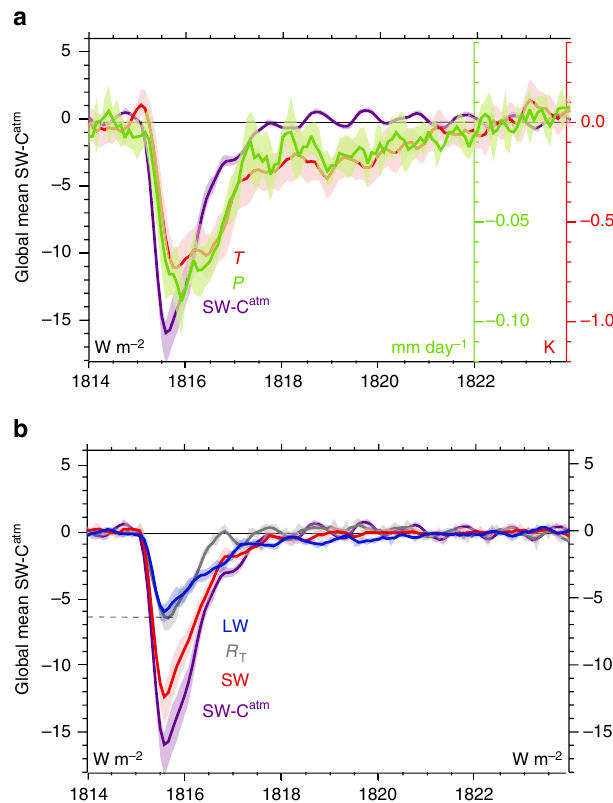
Fig. 3 Global mean-simulated responses to the 1815 eruption. Simulated anomalies relative to 1814 are shown in a global mean clear-sky shortwave fl ux through the atmosphere (SW-C atm ), 2-m air temperature ( T ), and precipitation ( P ), and b SW-C atm , global mean TOA incoming net ( R T ), shortwave (SW), and outgoing longwave (LW) radiation. Shading denotes the range of two standard errors. Years indicated on the abscissas begin at the corresponding tick